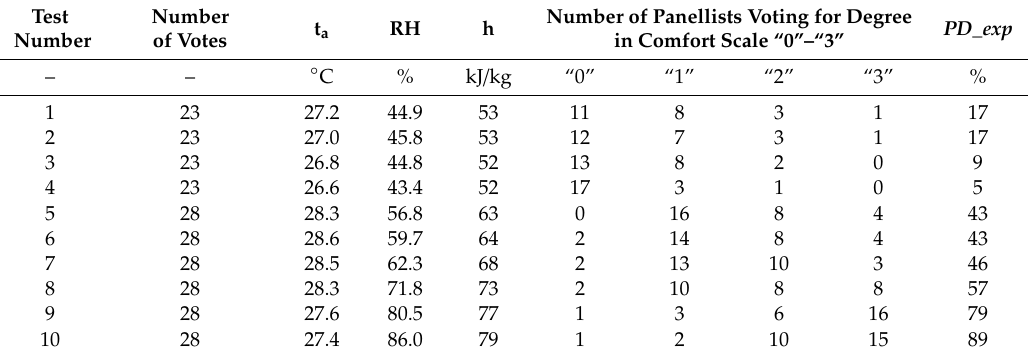
Table 5. Vote results—number of panellist votes using a 4-degree scale (whether prevailing air conditions are comfortable for work, where 0 is neutral (comfortable), 1 is just comfortable, 2 is just not comfortable, 3 is not comfortable) for 10 selected indoor conditions and the calculated percentage of dissatisfied (PD_exp).